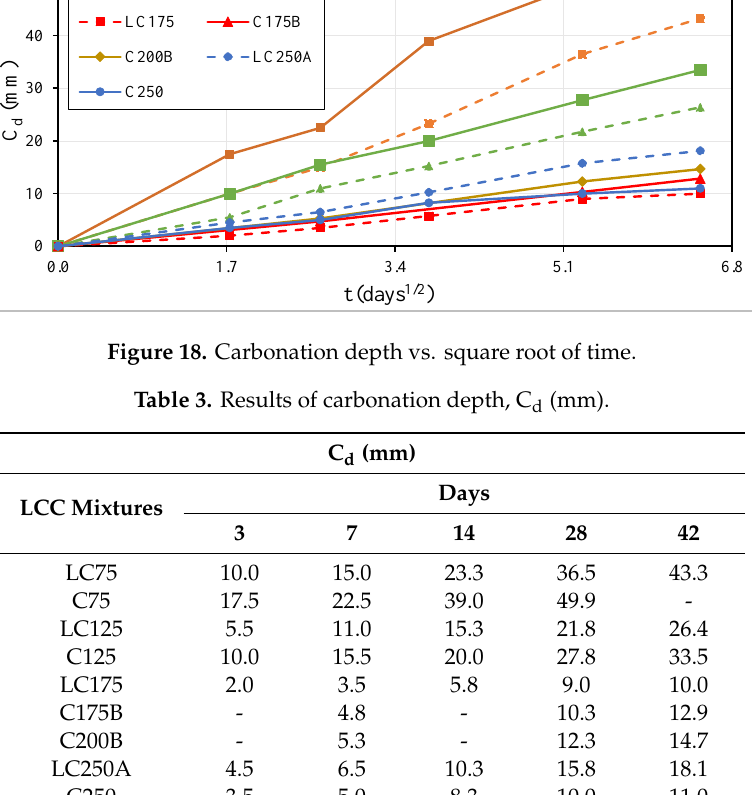
Figure 19. Relationship between C d vs. W/C eq .